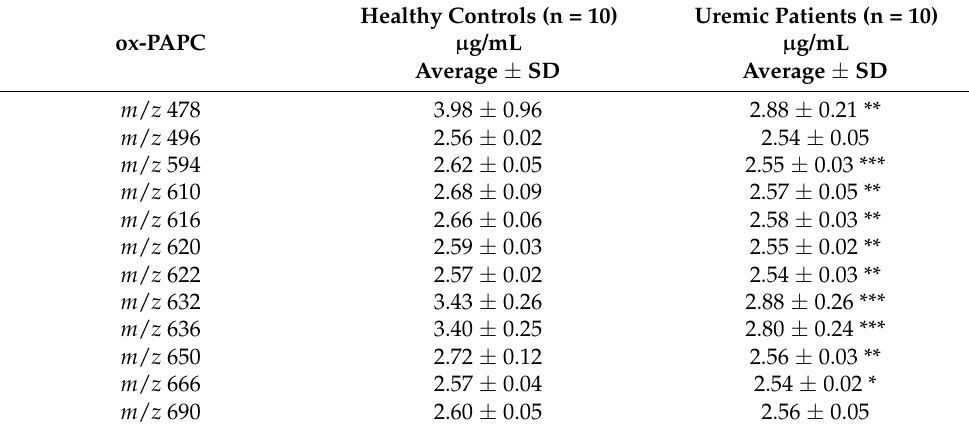
m / z 666 2.57 ± 0.04 2.54 ± 0.02 * m / z 690 2.60 ± 0.05 2.56 ±